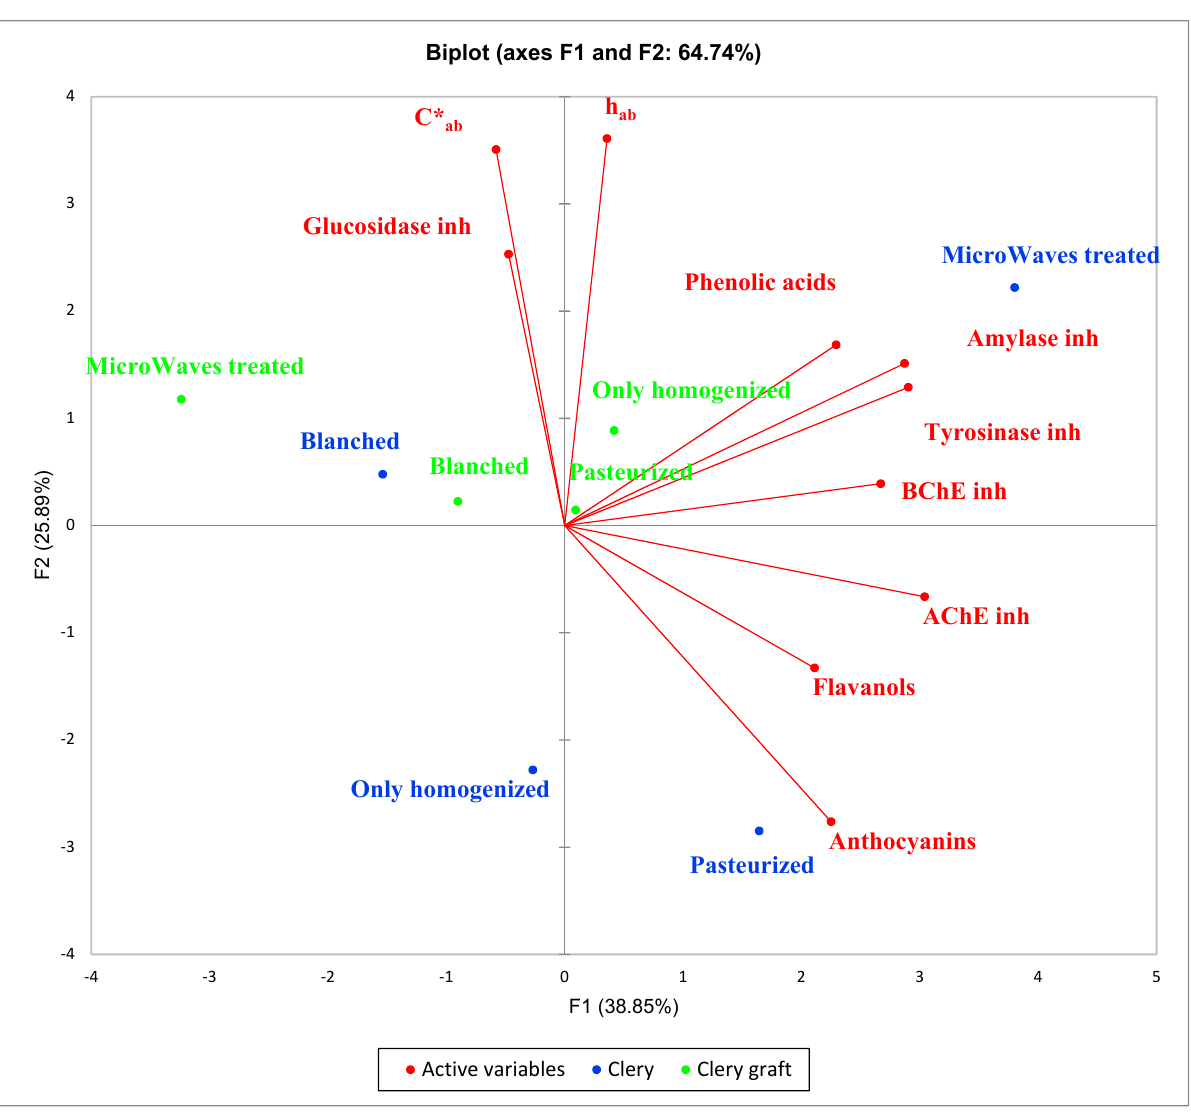
Figure 4. Principal component analysis (PCA) plots of the all strawberry samples analyzed.